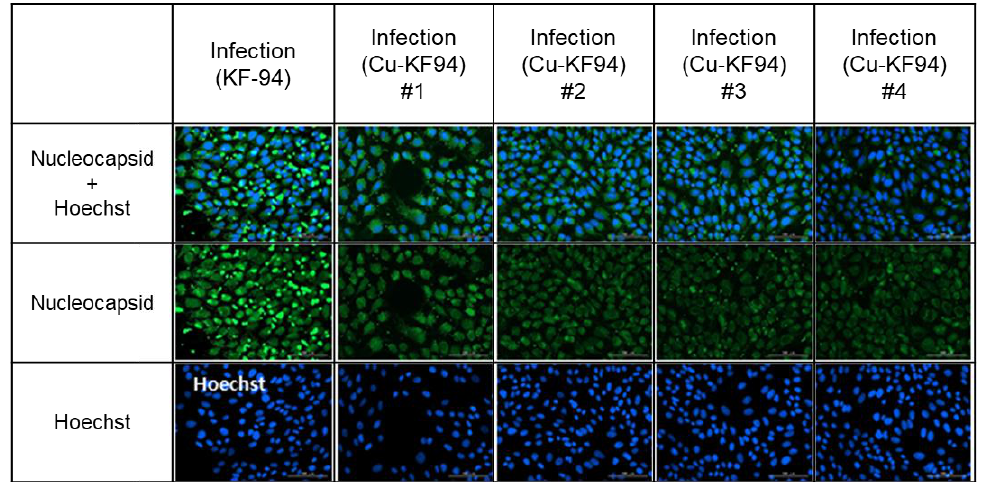
Figure 5. SARS-CoV-2 nucleocapsid expression after 1 h contact with uncoated ( n = 1) and copper-coated ( n = 4) KF94 masks (Cu-KF94).